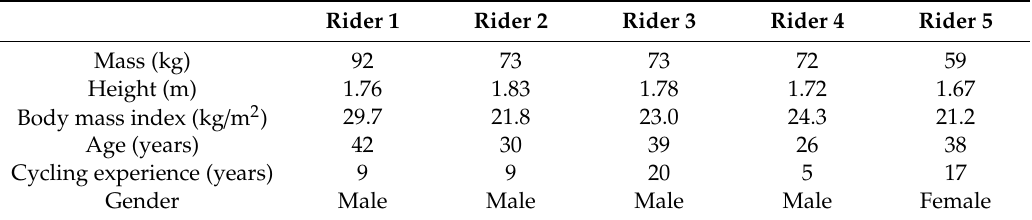
Table 1. Characteristics of the riders included in the